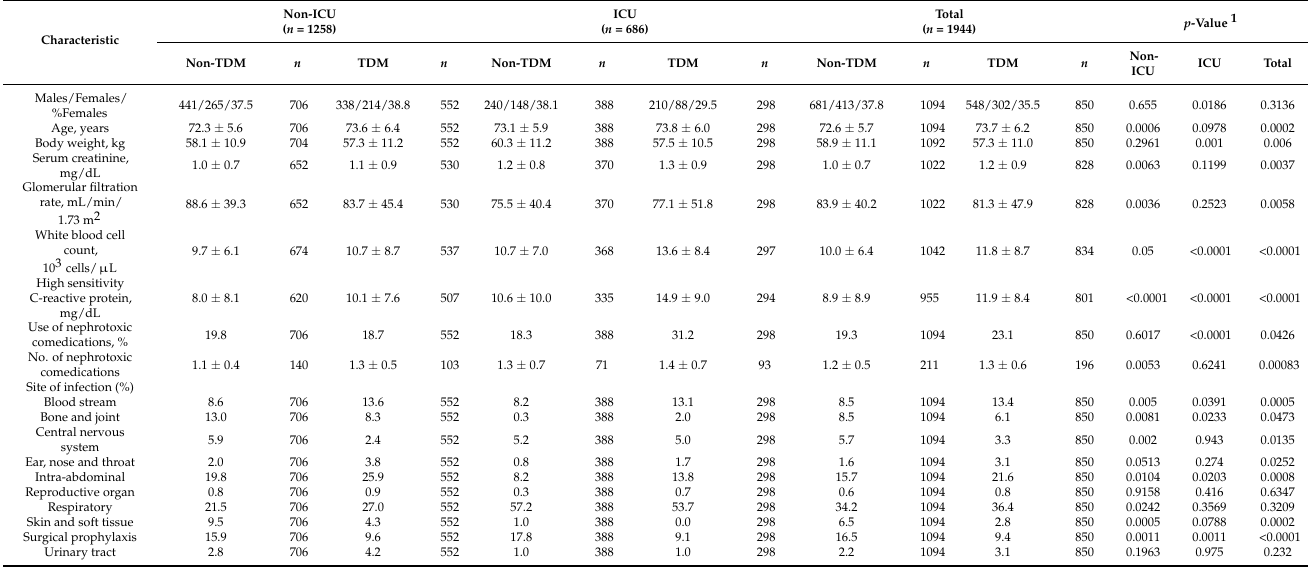
Table 1. Baseline demographic and clinical characteristics by ICU admission and TDM group.